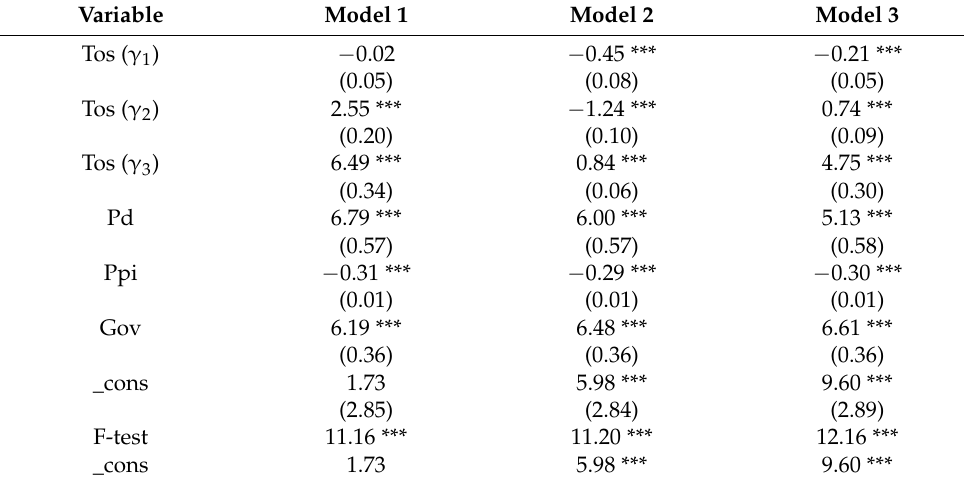
Table 7. Threshold panel model estimation